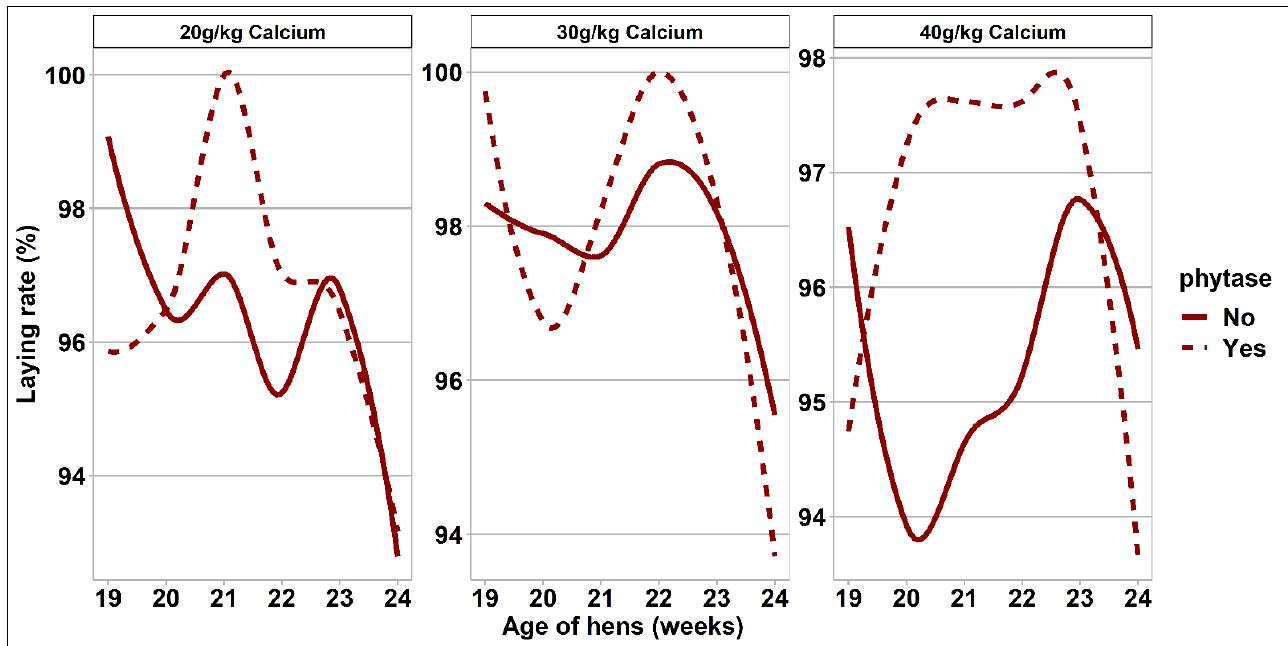
Figure 2. Trendlines visualizing the laying rate that hens of different dietary treatments experienced during the 6-week experimental period (n = 48).